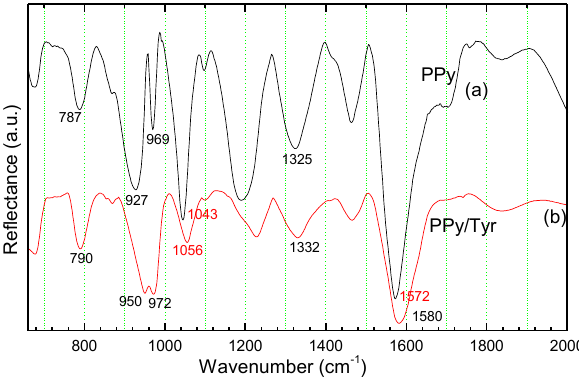
Figure 3. FTIR spectra for the PPy ( a ) and PPy/Try ( b ) films obtained after 10 voltammetric cycles.